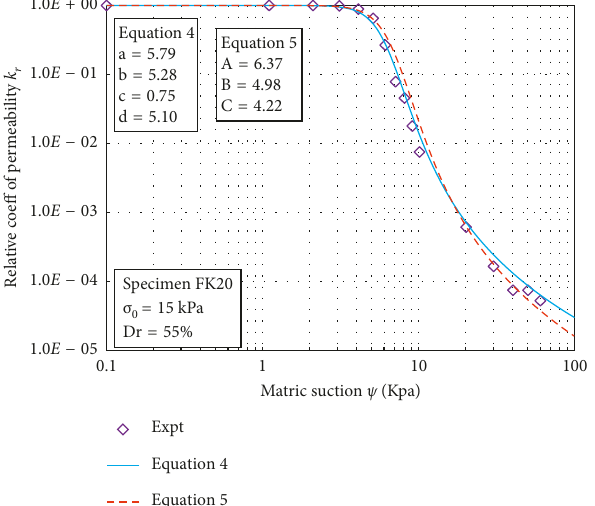
Figure 9: Permeability coefficient changes against matric suction for soil